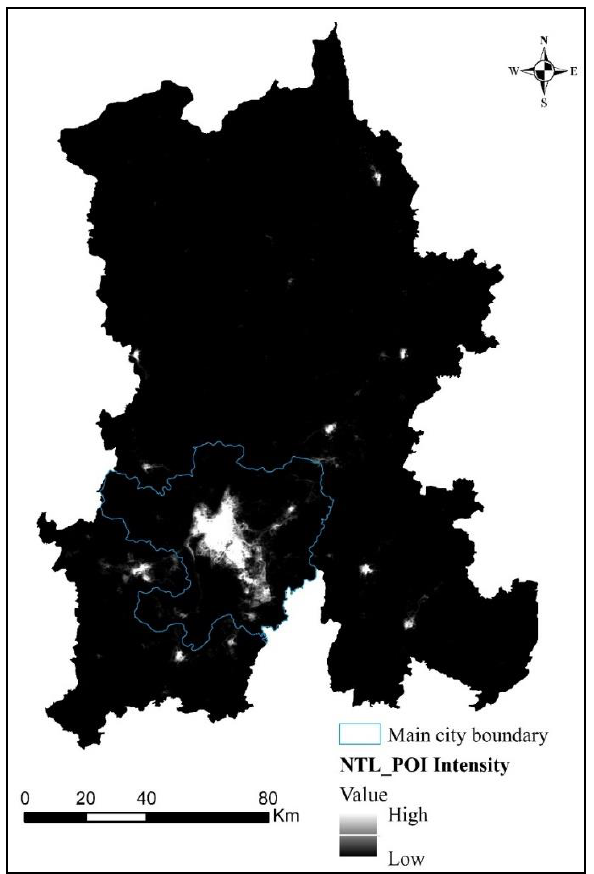
Figure 9. Variance curves of wavelet transform coefficients at different scales.